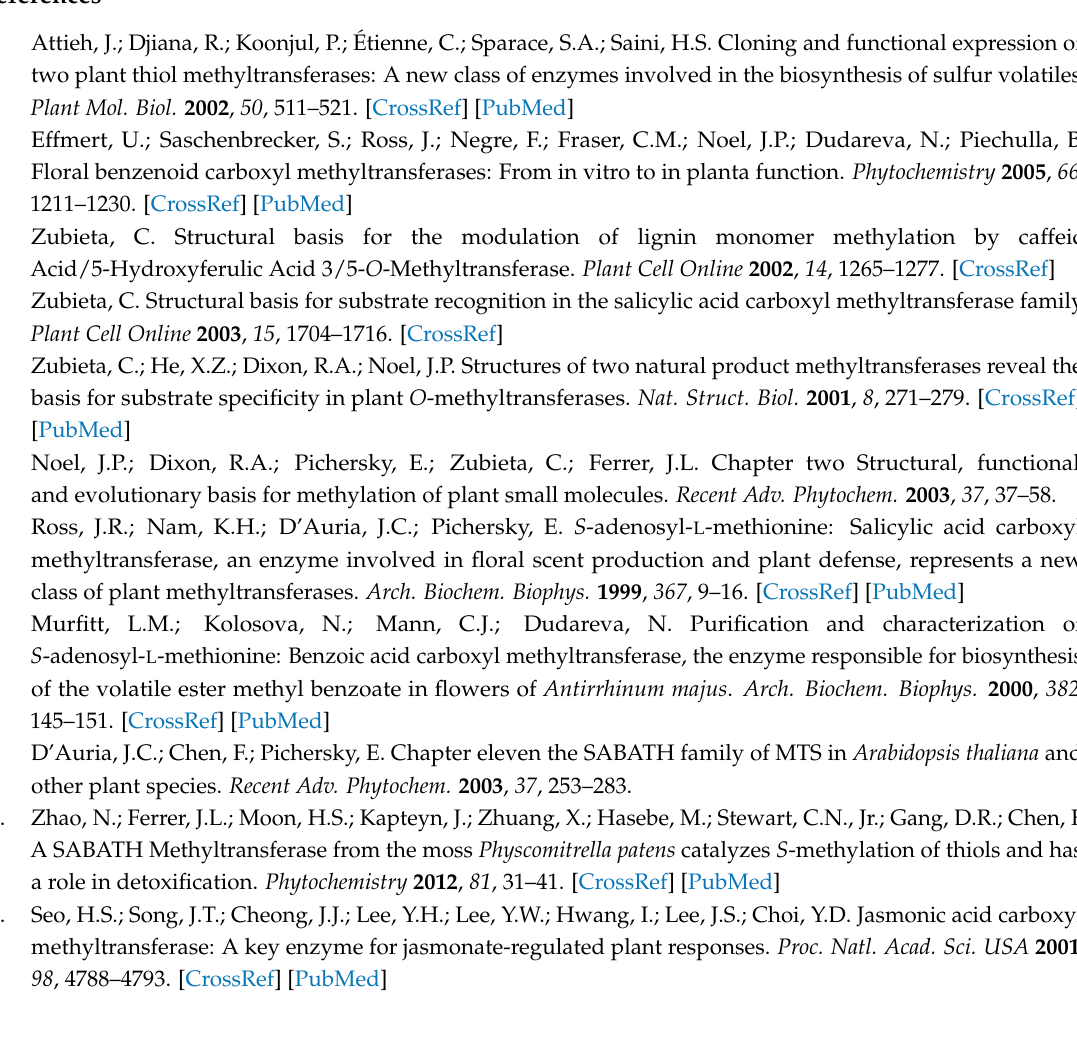
Table S1: List of the SABATH genes from other species. Table S2: Primers for qRT-PCR. Table S3: Gene features of SmSABATH . Table S4: Normal expression sequences of 13 motifs identified in 30 SmSABATH proteins. Table S5: The SABATH protein motif diagram of S. miltiorrhiza . Table S6: Ka/Ks and divergence analysis of SABATH paralogous in S. miltiorrhiza . Table S7: The coefficient of Type-I functional divergence ( θ I ) from pairwise comparisons between SmSABATH groups. Table S8: The coefficient of Type-II functional divergence ( θ II ) from pairwise comparisons between SmSABATH groups. Figure S1. Phylogenetic tree was reconstructed using the Bayesian inference method under the JTT + I + G model with the SmSABATH amino acid sequences. Figure S2. The neighbor-joining phylogenetic tree was reconstructed with SmSABATH amino acid sequences using MEGA